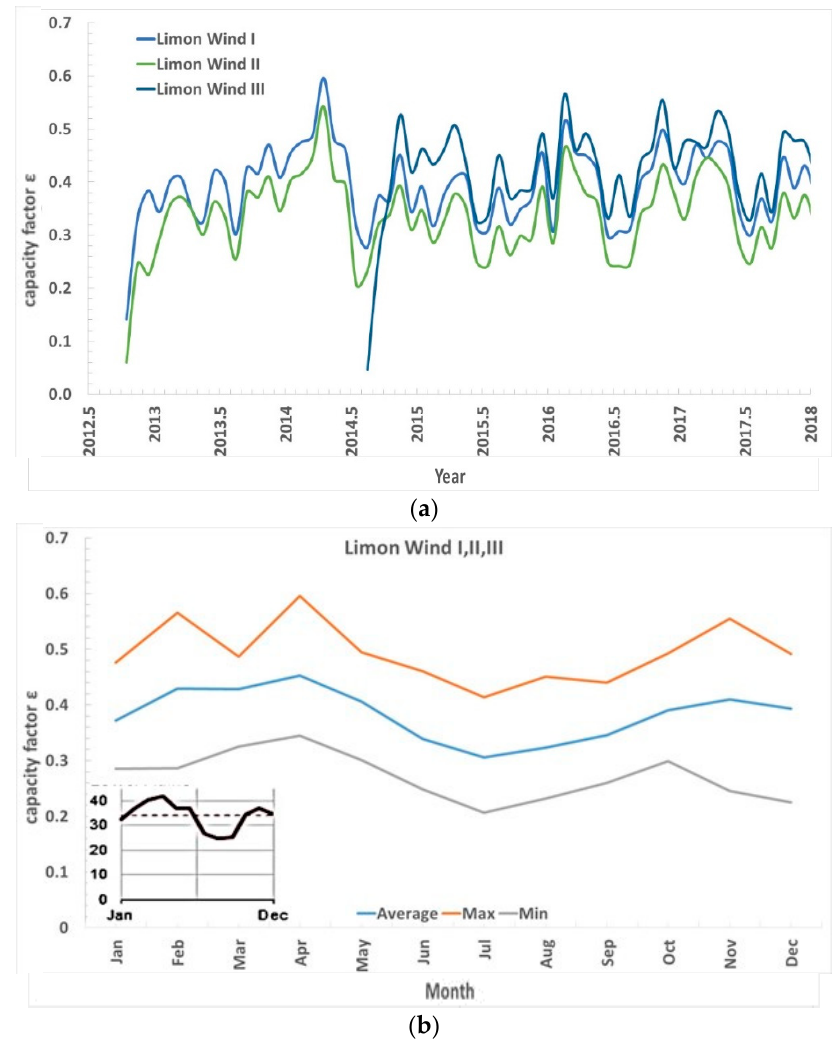
Figure 6. Limon Wind Energy Center units. ( a ) ε m since the start of the operation of the individual WEF. ( b ) Maximum, minimum, and average ε a of all the WEFs since the start of the operation of every WEF. The result compared with the reference seasonal variability for the Lower Plains according to [54], image reproduced modified after [54]. X-axis time, years ( a ), or months ( b ); Y-axis capacity factor ε (generating power vs. registered power) ε , non-dimensional.